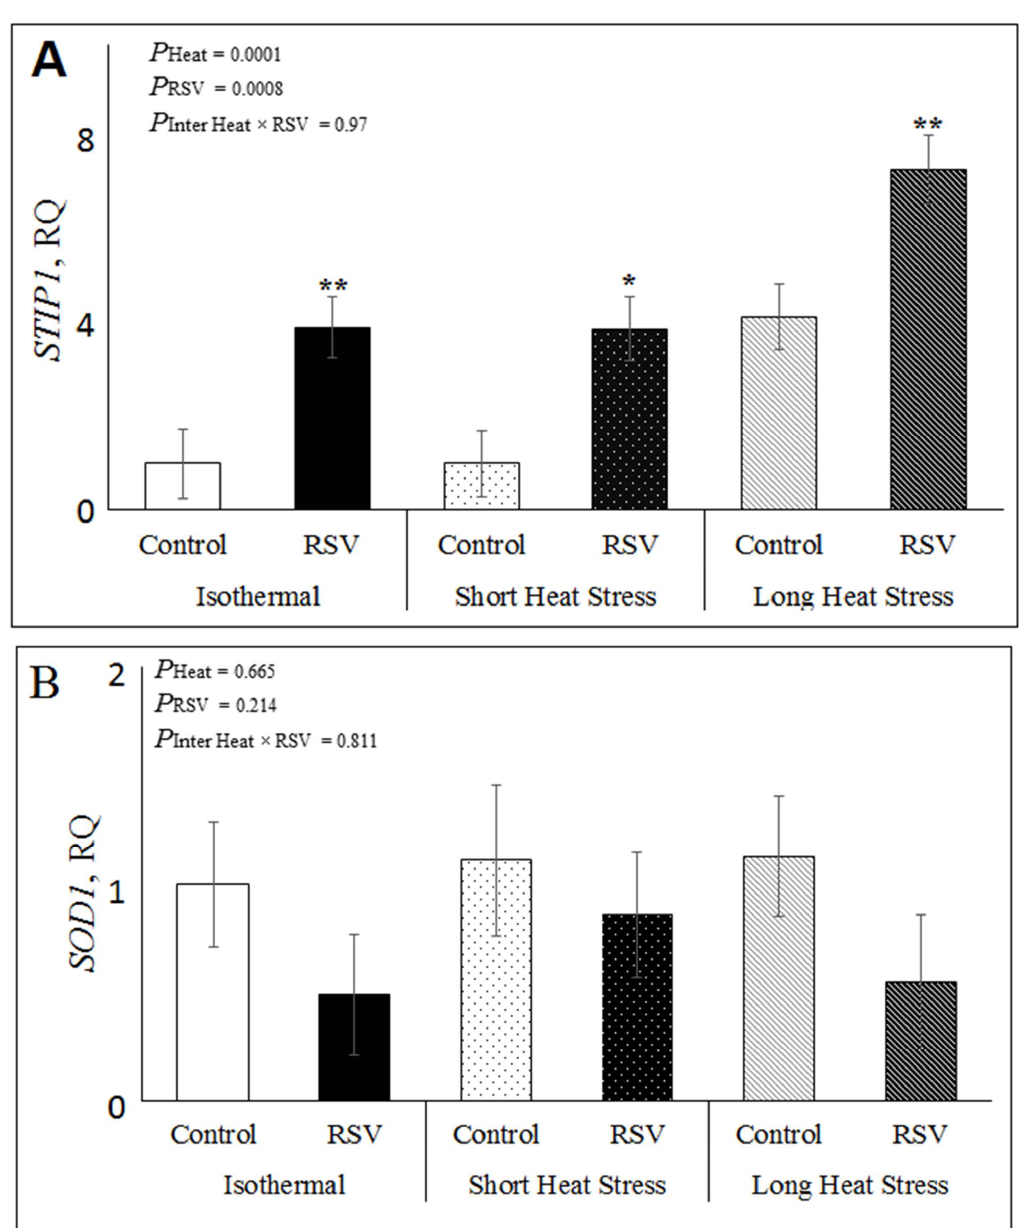
Figure 3. Effect of resveratrol (RSV; at 100 µ M for 48 h) under isothermal (ISO; 37 ◦ C for 48 h), short heat stress (SH; 37 ◦ C for 47 h and 41.2 ◦ C for last 1 h), or long heat stress (LH; 37 ◦ C for 32 h followed by last 16 h at 41.2 ◦ C) on relative expression of oxidative stress genes in DFAT cells. ( A ) Relative gene expression of stress induced phosphoprotein 1 ( STIP1 ); ( B ) Relative gene expression of super oxide dismutase 1 ( SOD1 ). P heat is the significance of heat stress treatments, P RSV is significance for RSV treatment and P inter Heat × RSV is significance of interaction of Heat × RSV. Within each heat treatment, * indicates p < 0.05 and ** indicates p < 0.01 between control and RSV treatments.